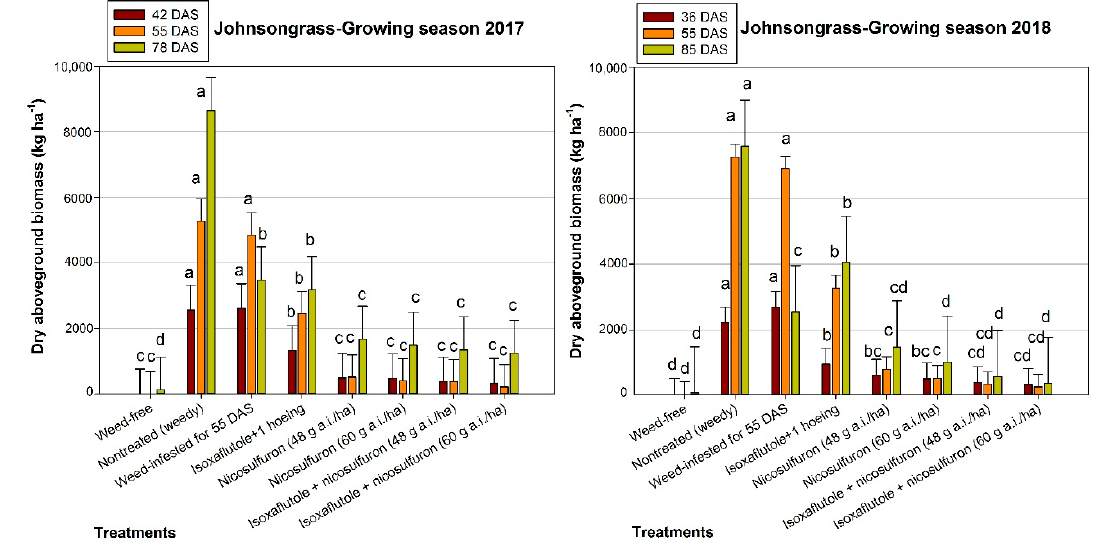
Figure 2. Johnsongrass aboveground biomass (kg ha − 1 ) as affected by the various treatments at 36–42 days after sowing (DAS), 55 DAS, and 78–85 DAS, in 2017 and 2018 (Velestino, Greece). For each measurement, bars followed by different letters indicate significant differences according to Fisher’s LSD test ( p ≤ 0.05). Error bars indicate the LSD 5% values.